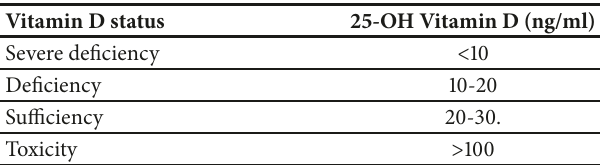
Table 1: The ranges for the classification of 25-hydrxyvitamin D status